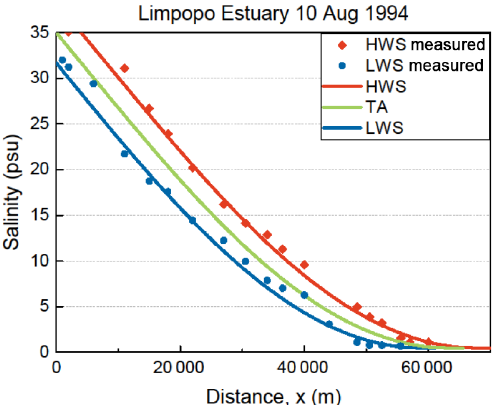
Figure 4. Application of the numerical solution to observations in the Maputo Estuary for high water slack (HWS) and low water slack (LWS). The green line shows the tidal average (TA) condition. The red diamonds reflect the observations at HWS and the blue dots the observations at LWS on 29 May 1984.